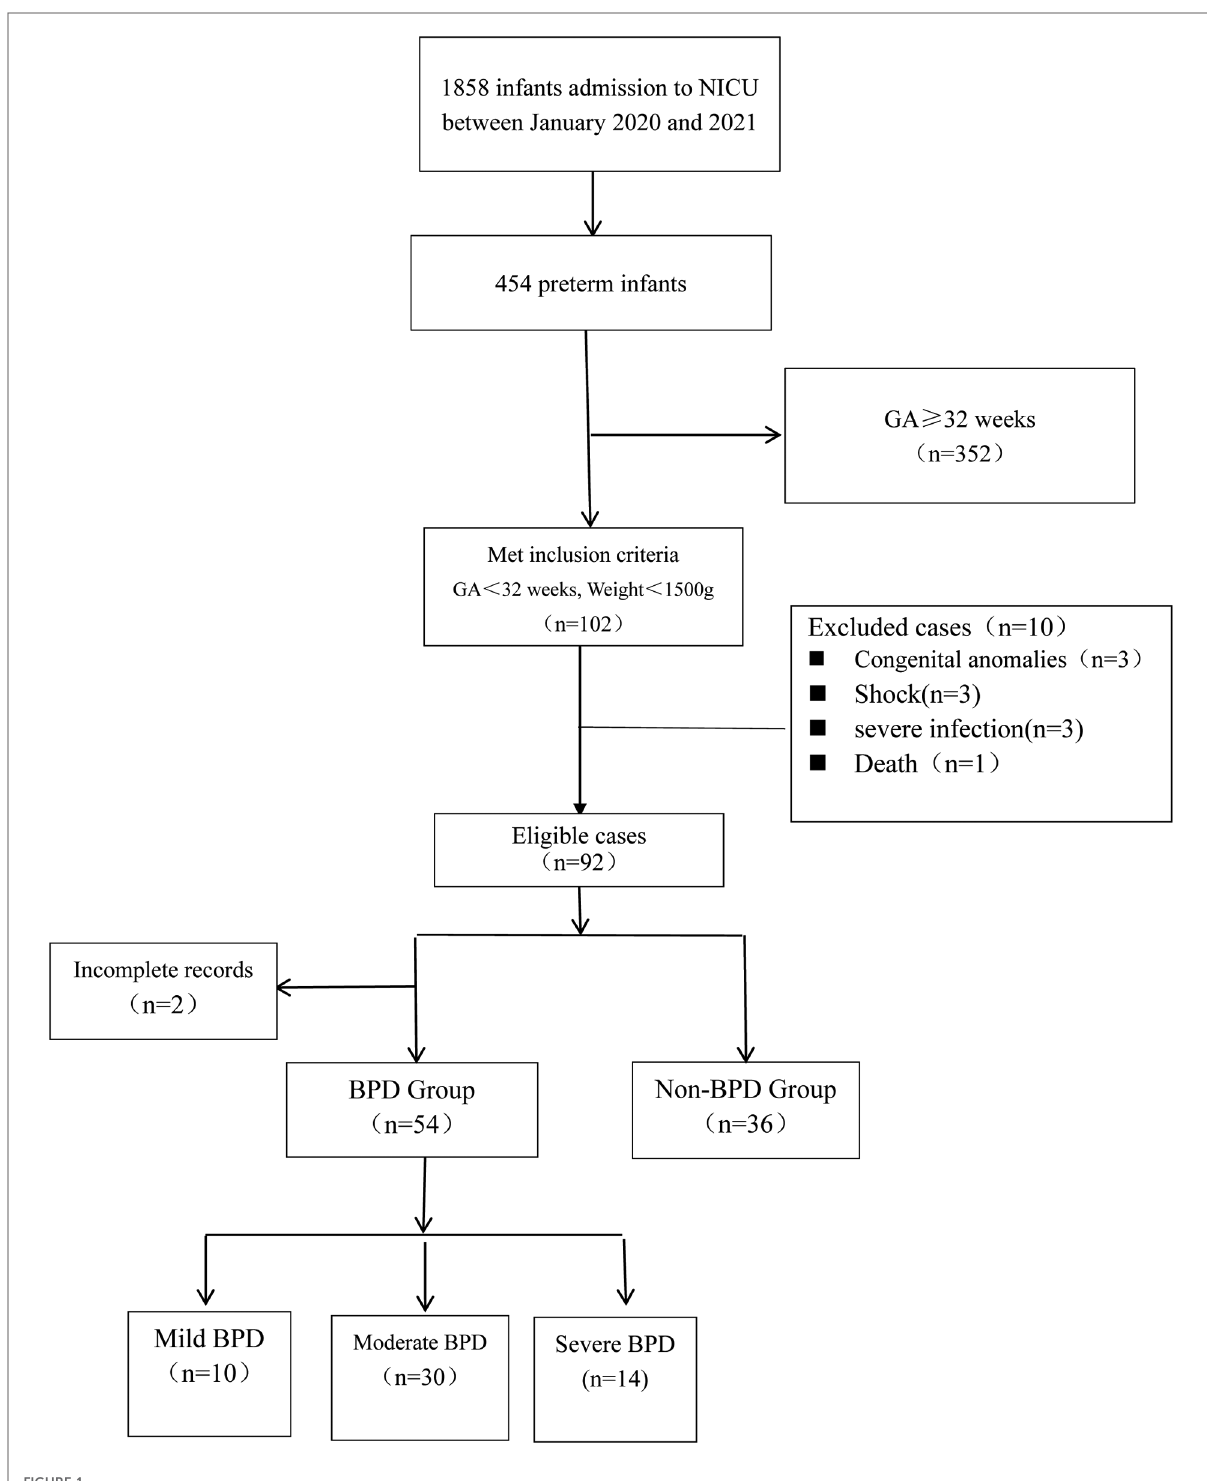
FIGURE 1 Flow chart for patient